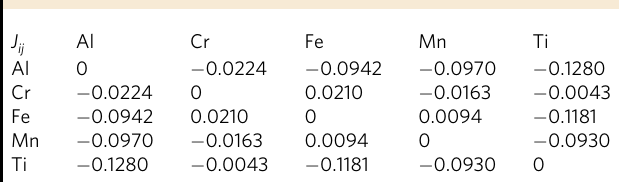
Table 2 The nearest-neighbor interaction parameters, J